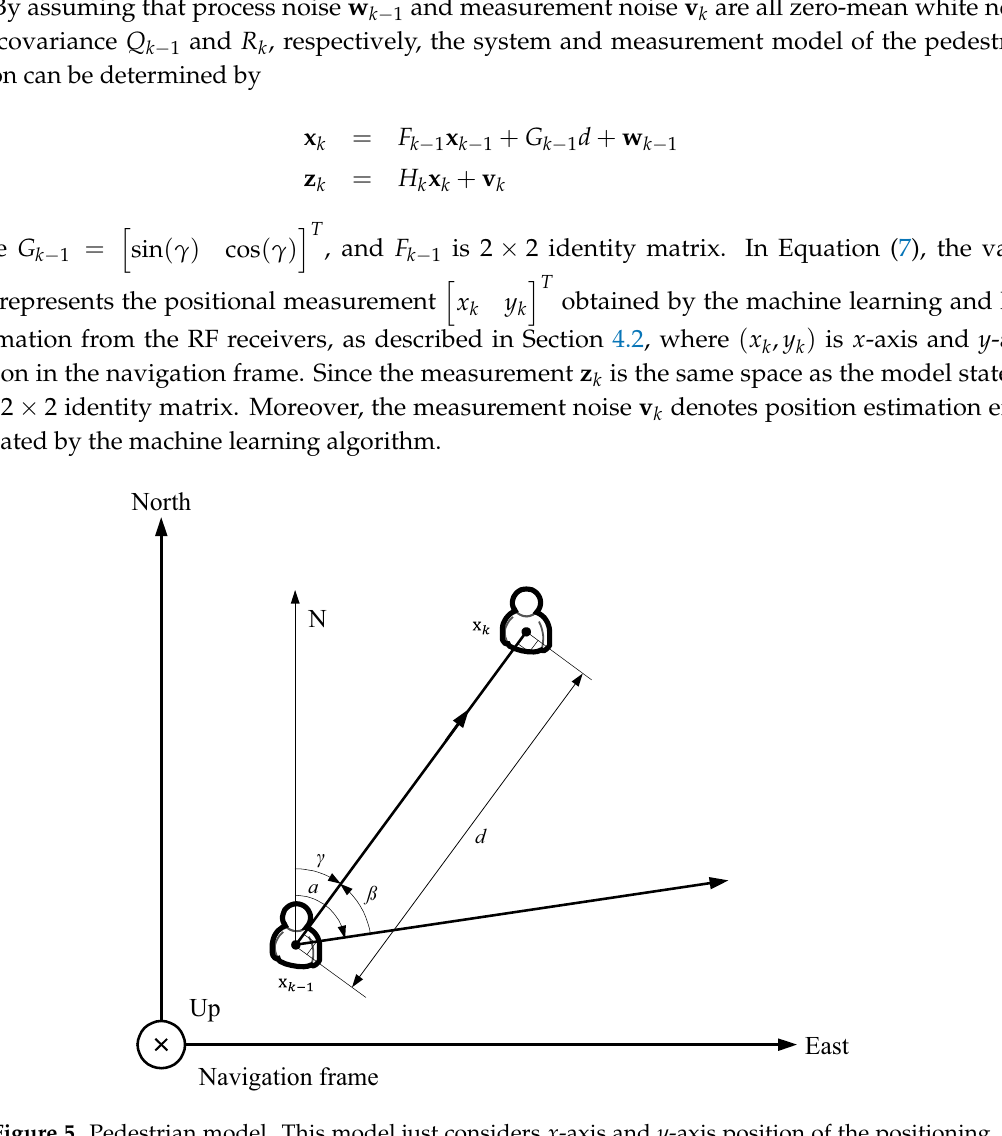
Figure 5. Pedestrian model. This model just considers x -axis and y -axis position of the positioning system user in the navigation